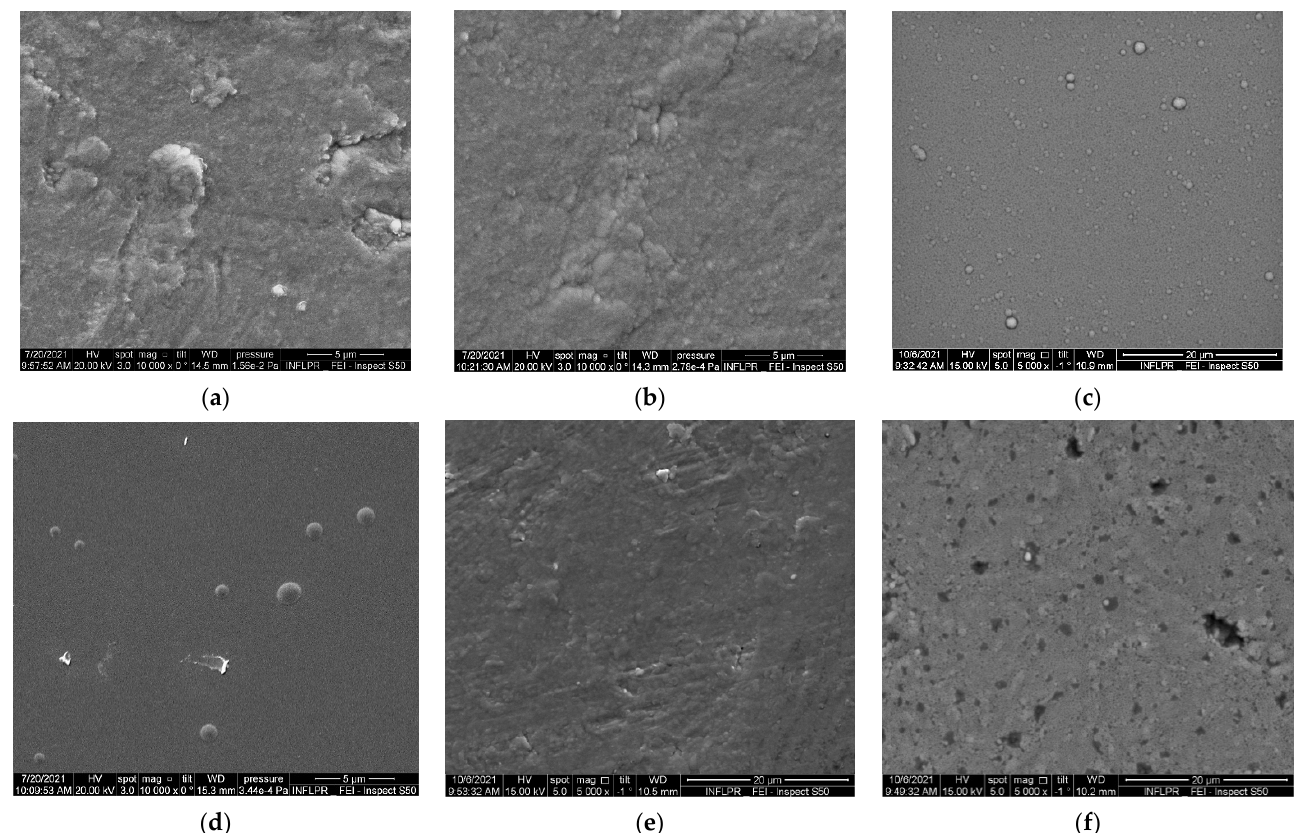
Figure 4. SEM images of oxides and metal-oxides at 5 k and 10 k × magnification for S1 ( a ), S2 ( b ) S3 ( c ), S4 ( d ), S5 ( e ), and S6 ( f ).